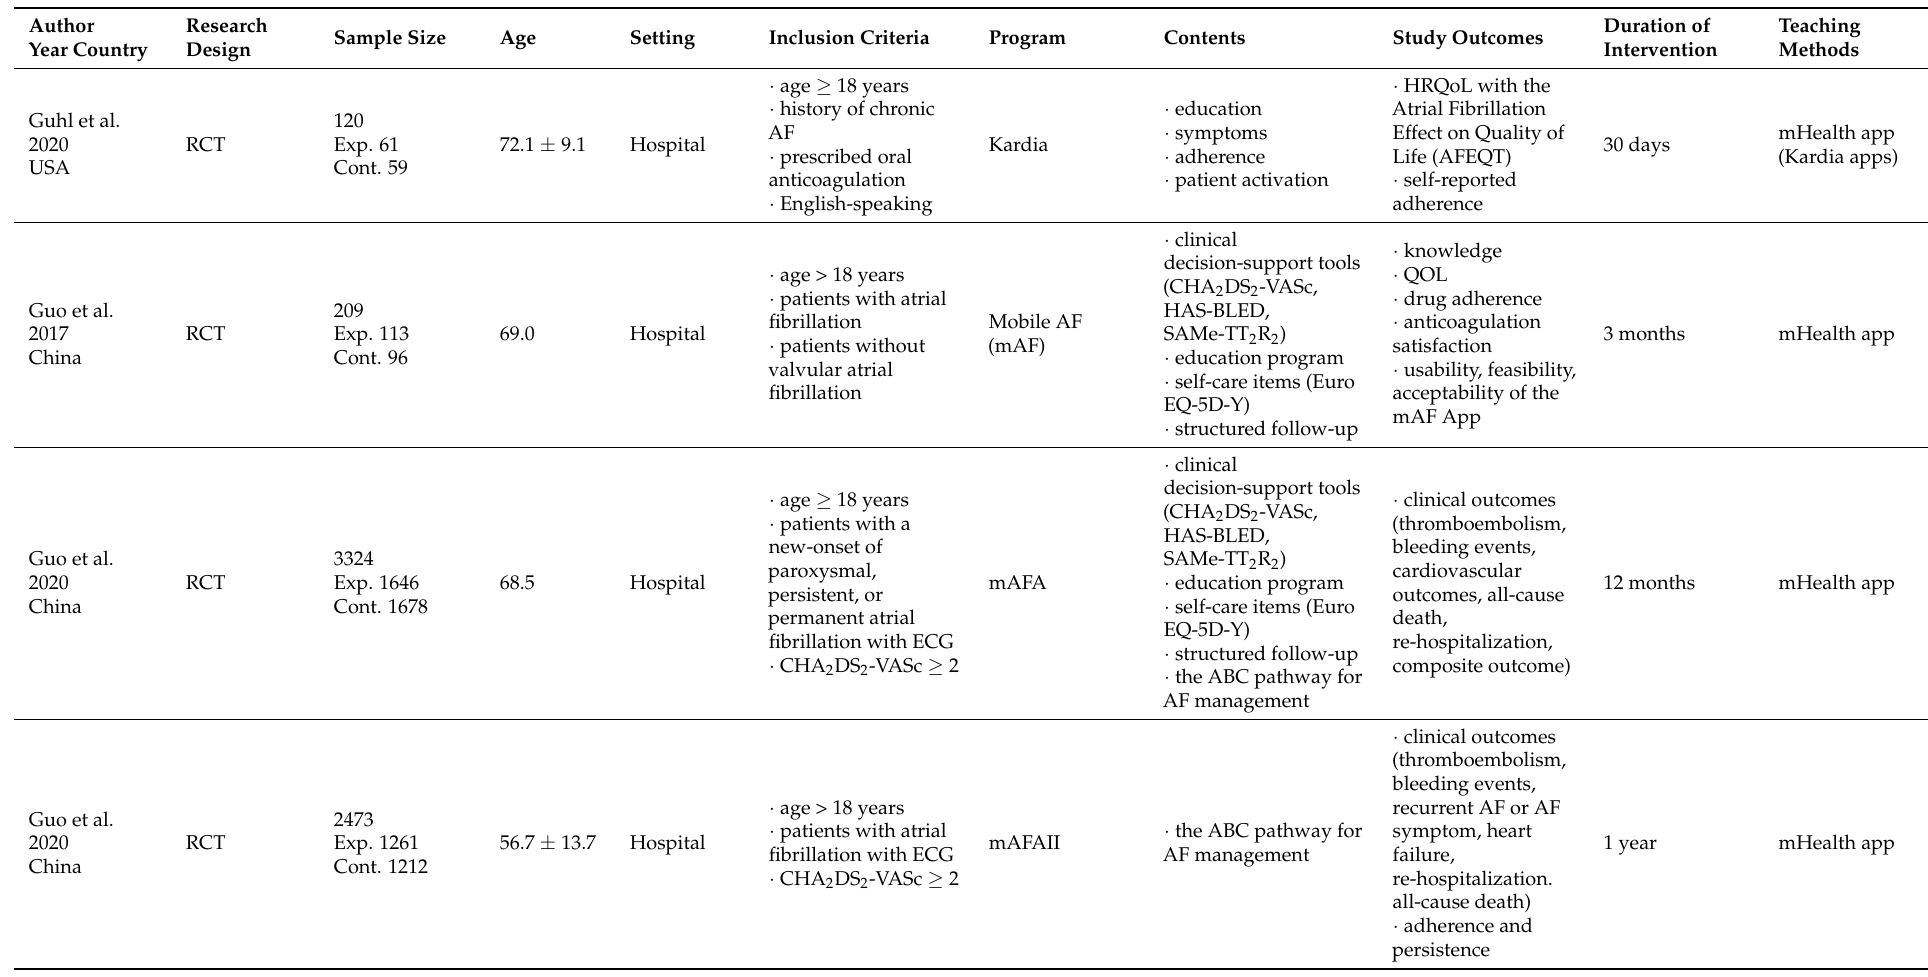
Table 2. Characteristics of the mobile health program and detailed contents of the participants taking